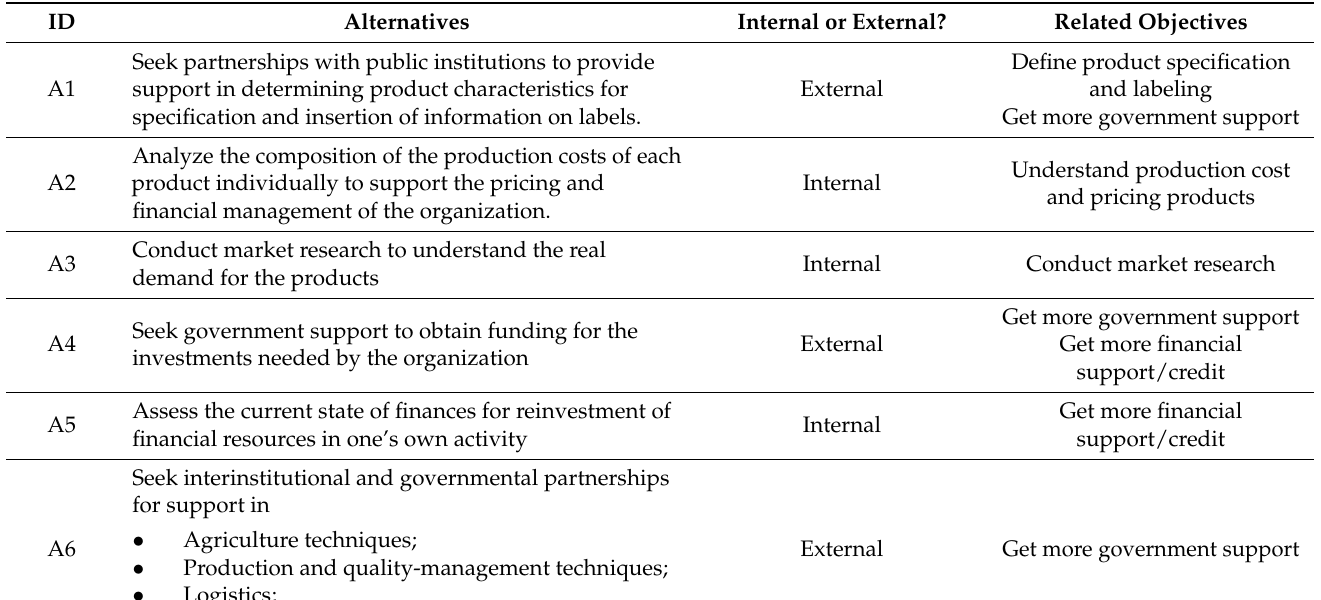
Table 1. Alternatives